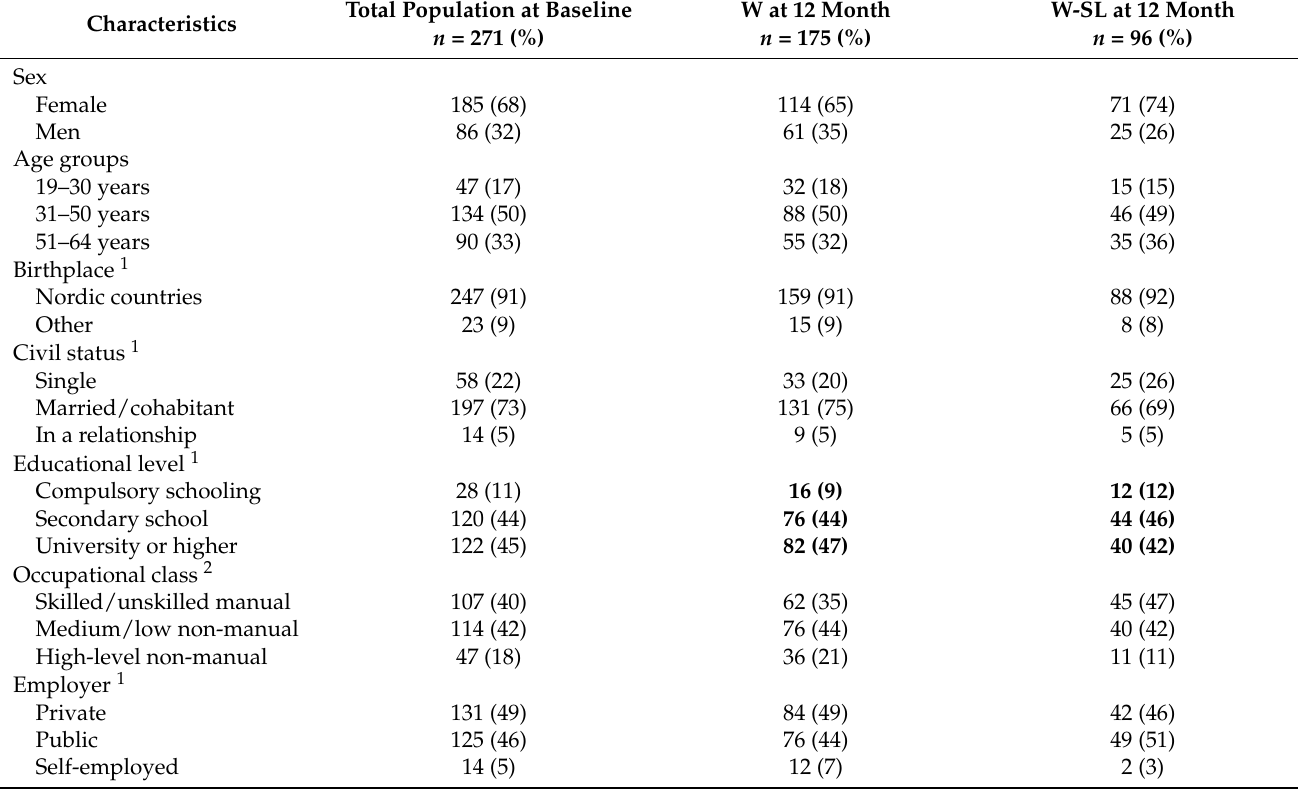
Table 1. Baseline characteristics of the study population, n = 271, and workers without (W) and with sick leave (W-SL) at 12-months